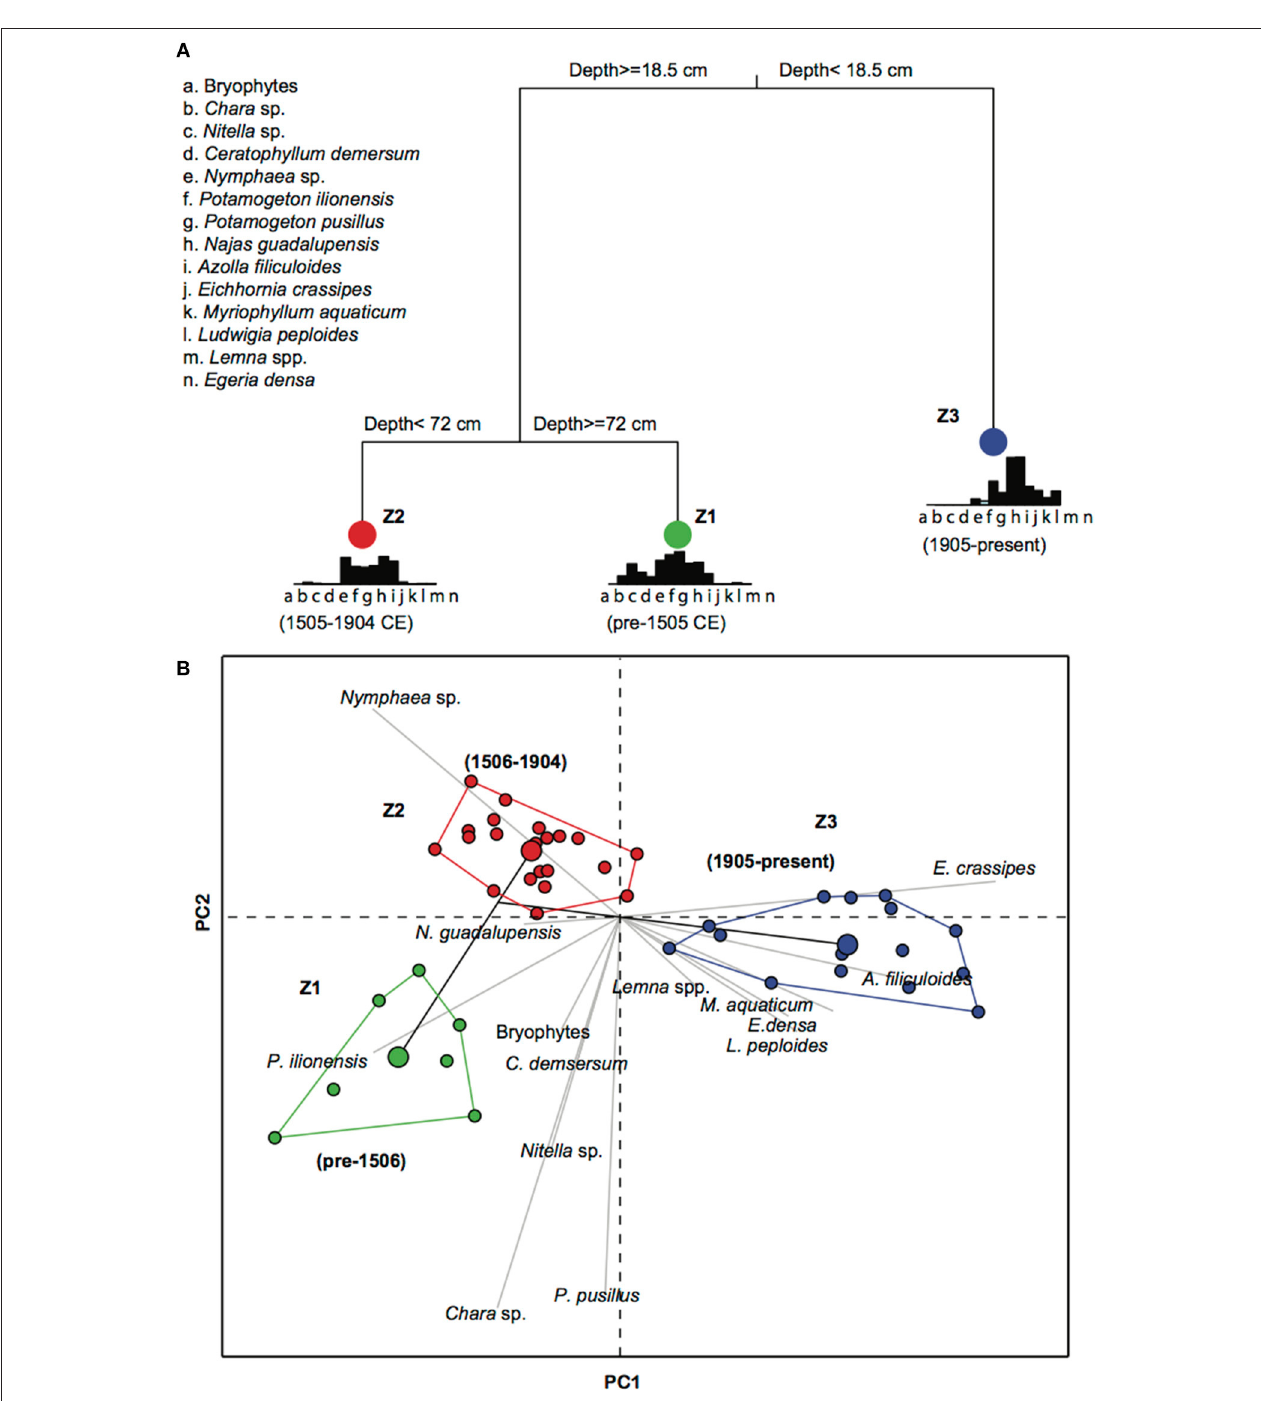
FIGURE 7 | (A) Example of one of the 10 univariate regression tree analyses showing the main zones of plant macrofossil variation recorded in the cores LFUQ-WH1 and LFUQ-M1; (B) Principal component analysis (PCA) showing plant macrofossil associations at the three temporal zones denoted by regression tree analysis. Green, Z1 CE c.pre-1506 BD; red, Z2 CE 1506-1904; blue, Z2 1905 CE-present. Color dots within each group represent the plant macrofossil sampling intervals in both cores. The larger color dot within each group represents the group centroid value.